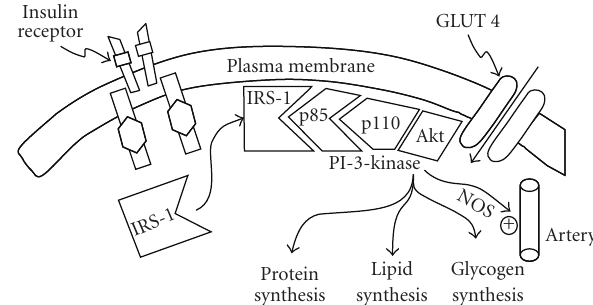
Figure 4: Insulin signal transduction system in normal glucose tolerant subjects (see text for a detailed